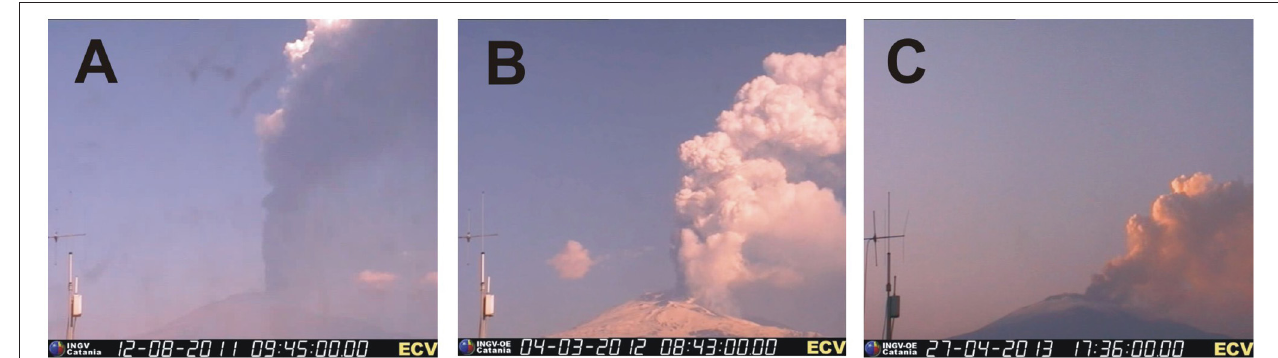
FIGURE 1 | Images taken from the ECV visual camera (see Table 1 and Figure 2 for details) showing: (A) a strong plume formed during the episode of 12 August 2011 at 09:45; (B) an intermediate plume formed during the episode of 4 March 2012 at 08:43; (C) a weak plume bending eastward during the episode of 27 April 2013 at